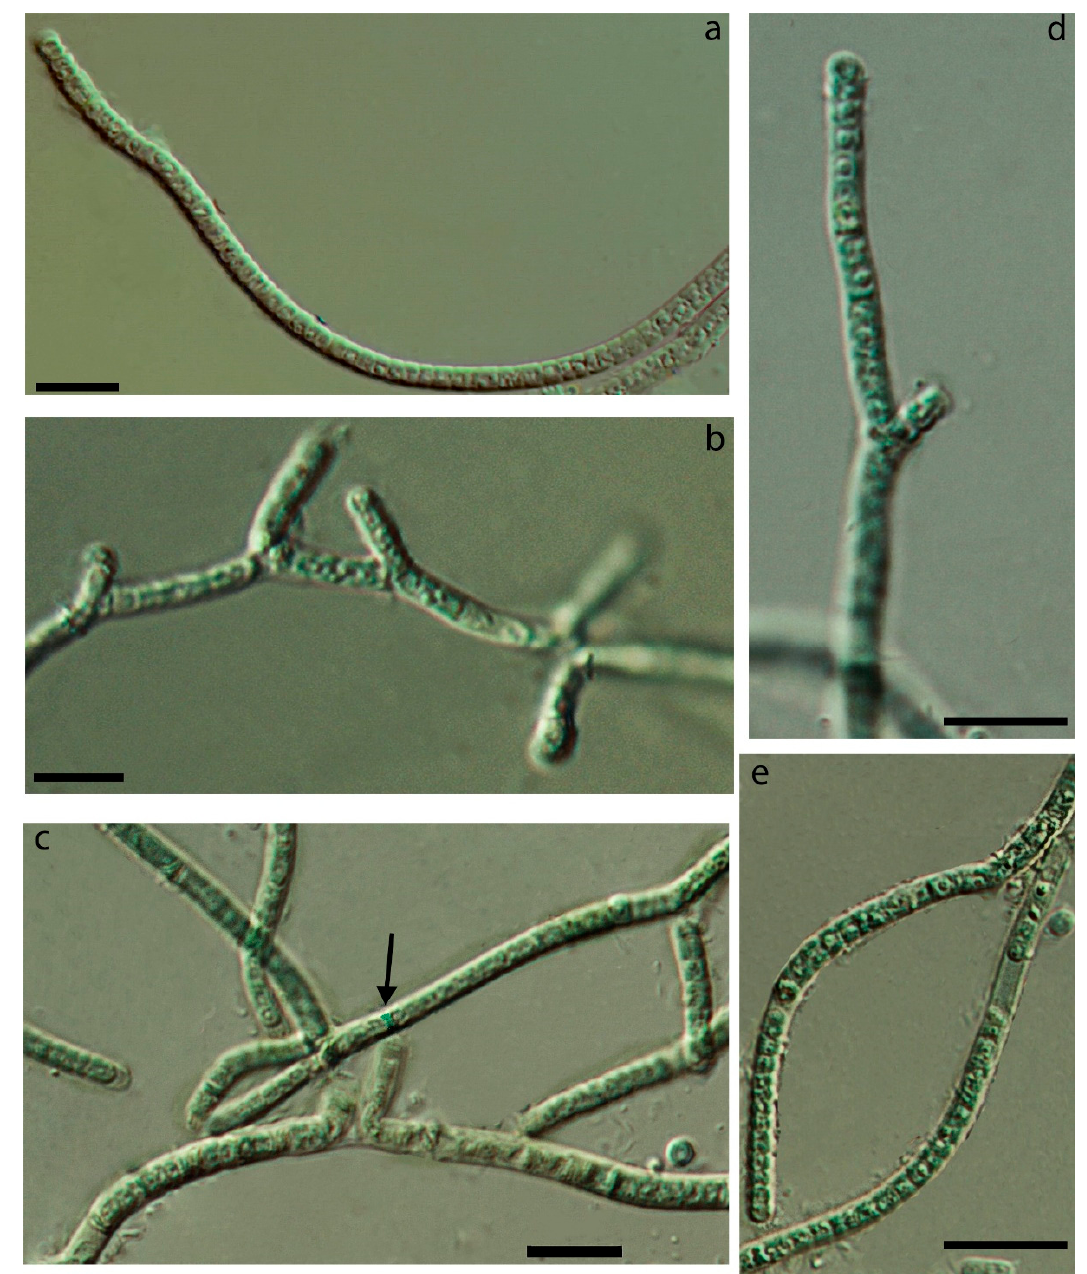
Figure 3. Light micrographs of the Drouetiella SYKOA C-013-09 strain: ( a , e ) unbranching filaments with thin, firm sheaths; ( b – d ) false-branching filaments; ( e ) filaments with thin, firm sheaths. The arrow indicates a necridia. All photos are at the same magnification, scale = 10 μ m.